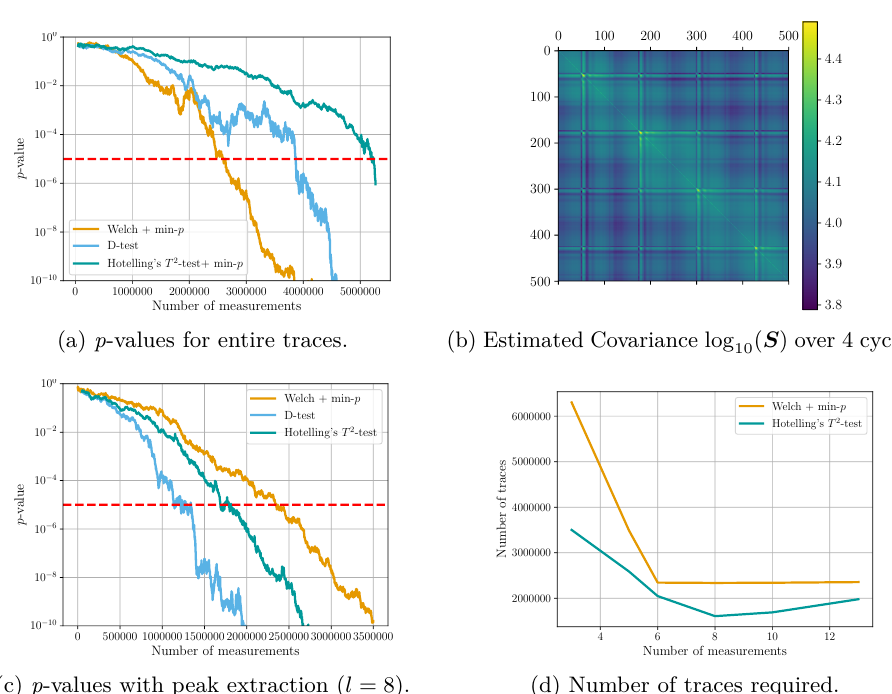
Figure 10: Leakage detection results using the measurements of a masked hardware AES implementation protected by DOM with two